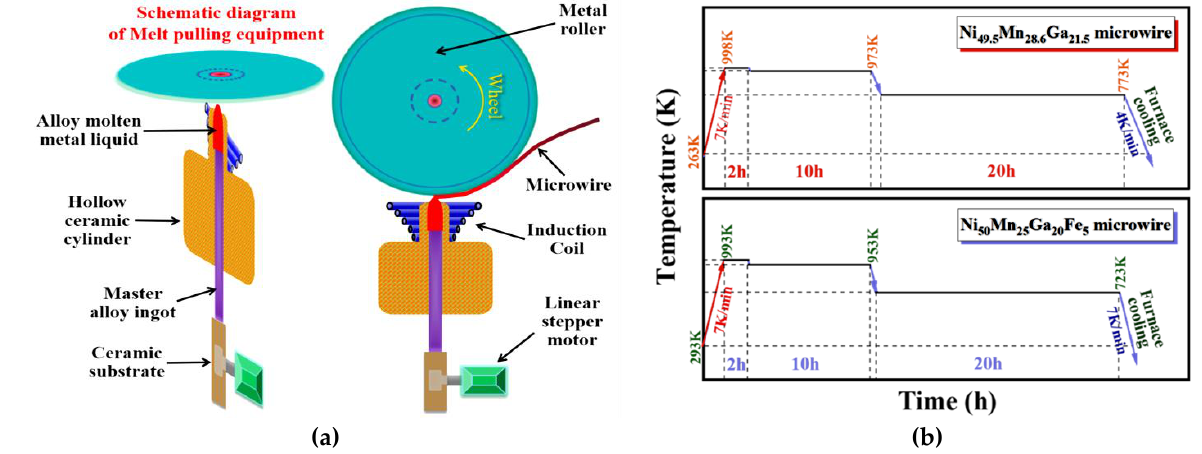
Figure 1. ( a ) Principle diagram of melt drawing equipment, ( b ) ordered heat treatment